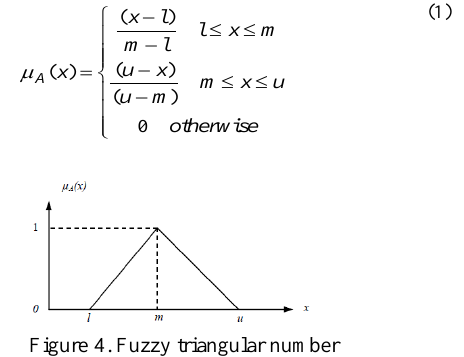
Figure 4. Fuzzy triangular number